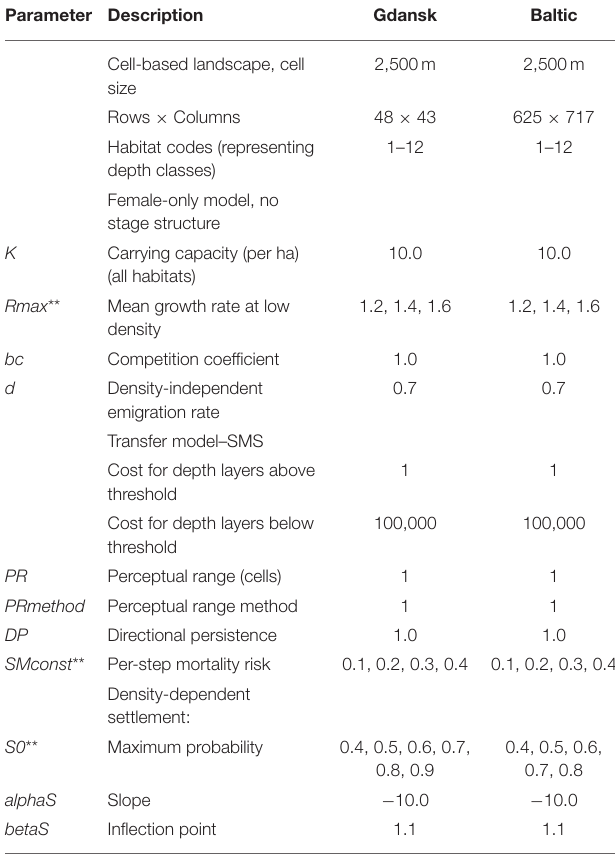
TABLE 1 | RangeShifter settings and parameter values for Gulf of Gdansk and Baltic Sea models. Parameter